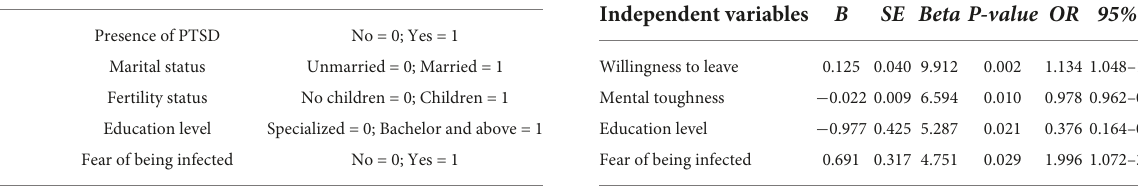
TABLE 4 Multifactorial analysis of post-traumatic stress disorder ( n =